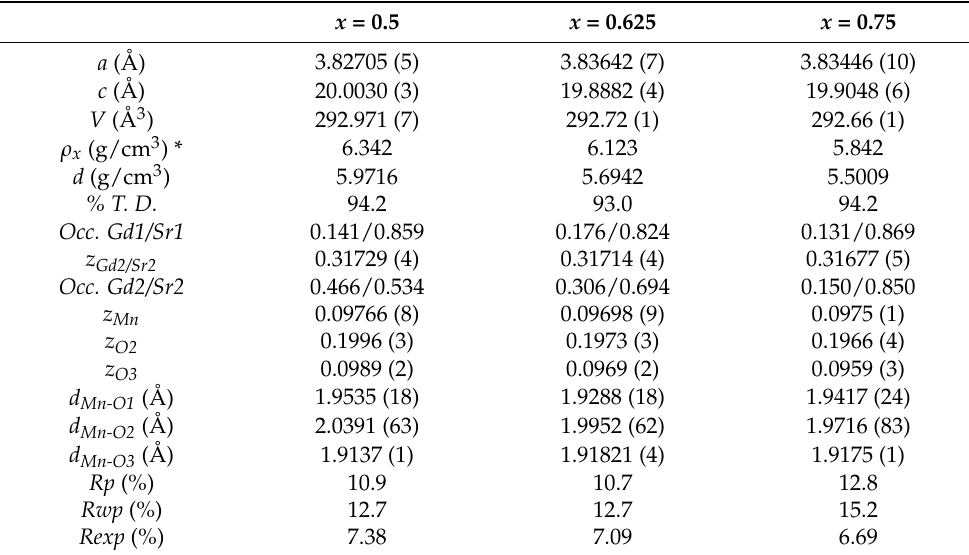
Table 2. The measured compositions from EDS results for Gd 2 − 2 x Sr 1+2 x Mn 2 O 7 ( x = 0.5, 0.625, 0.75) . EDS Composition (at.%)